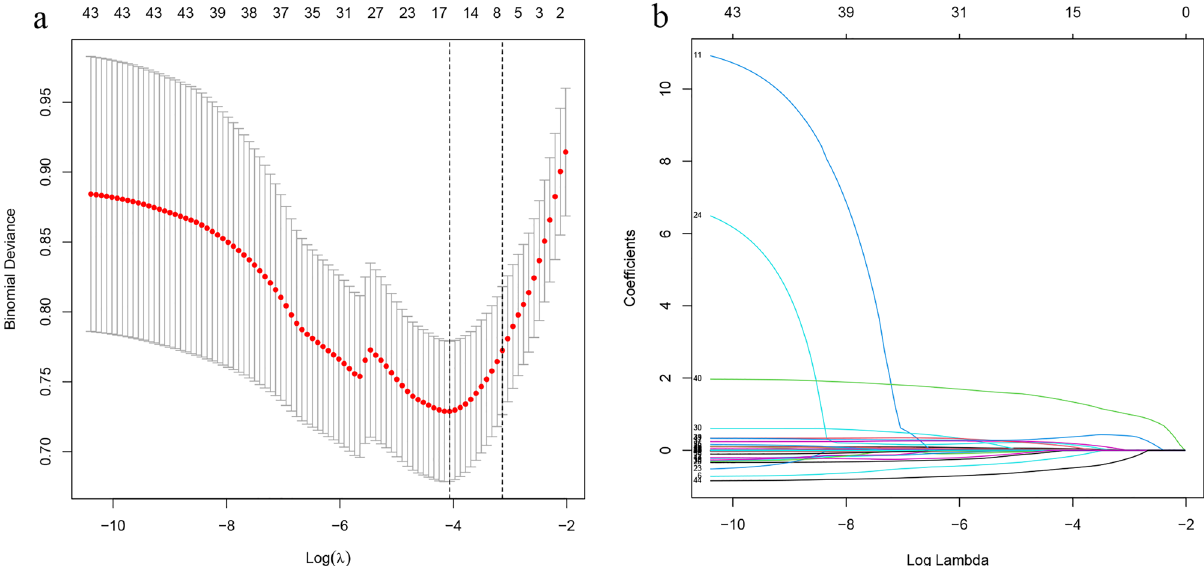
Figure 1. Selection of risk factors contributing to mortality within 1 year in NIDCM patients using the LASSO regression model. ( a ) Optimal parameter (lambda) selection in the LASSO model used five-fold cross- validation via minimum criteria. The partial likelihood deviance (binomial deviance) curve was plotted against log(lambda). Dotted vertical lines were drawn at the optimal values by using the minimum criteria and a SE of 1 for the minimum criteria (the 1-SE criteria). ( b ) LASSO coefficient profiles of the 42 features. A coefficient profile plot was generated against the log(lambda)